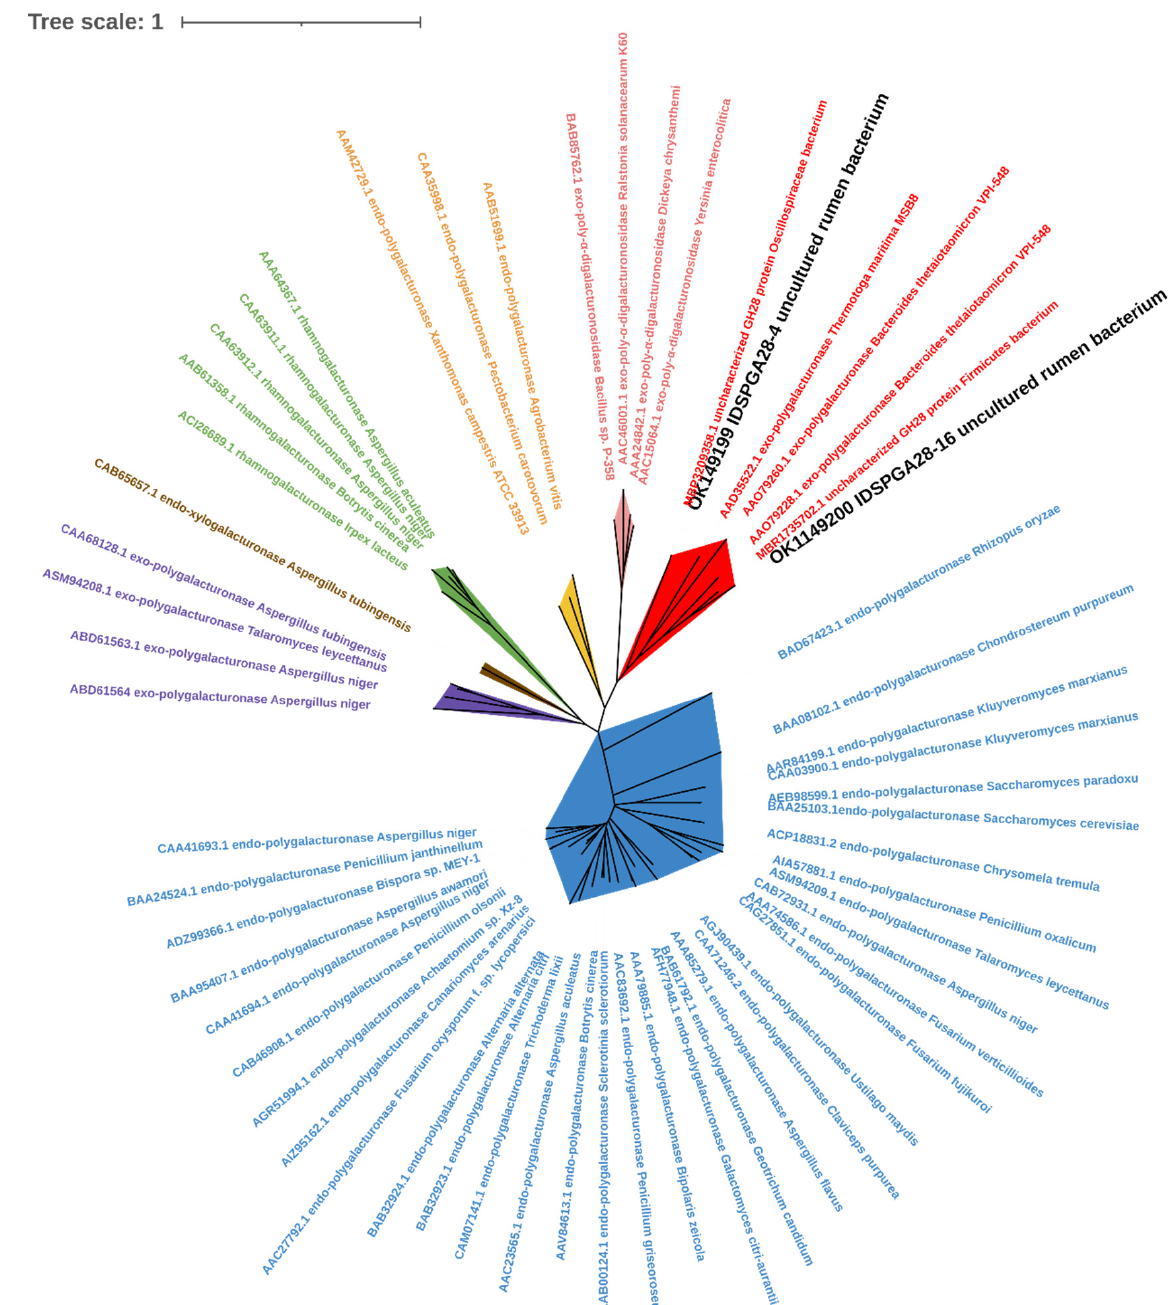
Figure 1. Phylogenetic analysis of IDSPGA28-4 and IDSPGA28-16. Color-coding is as follows: cherry: bacterial exo-polygalacturonase (EC 3.2.1.67); plum: bacterial exo-poly- α -digalacturonosidase (EC 3.2.1.82); yellow: bacterial endo-polygalacturonase (EC 3.2.1.15); green: fungal rhamnogalac- turonase (EC 3.2.1.171); brown: fungal endo-xylogalacturonase (EC 3.2.1.-); violet: fungal exo- polygalacturonase (EC 3.2.1.67); azure: fungal endo-polygalacturonase (EC